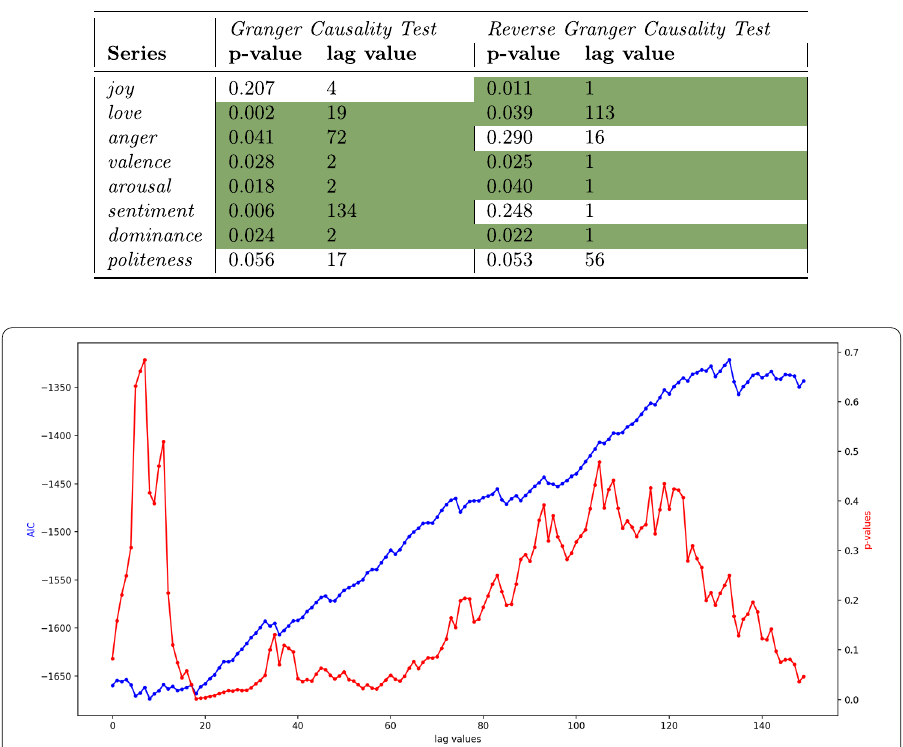
Figure 5 Ethereum—Love AIC and p -values. AIC values (see Eq. (6)) (blue line) and p-values (red line) as a function of the number of lags